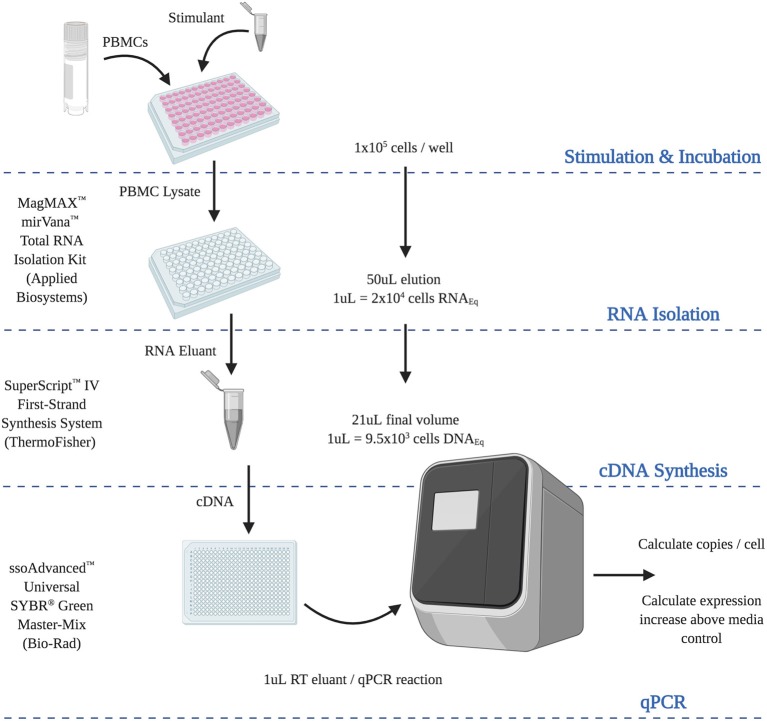
Final optimized RT-qPCR assay. Steps and calculations required for the use of the optimized analytically and diagnostically sensitive RNA extraction and RT-qPCR protocol, from peripheral blood mononuclear cells. (RNAEQ, RNA equivalent; DNAEQ, DNA equivalent).